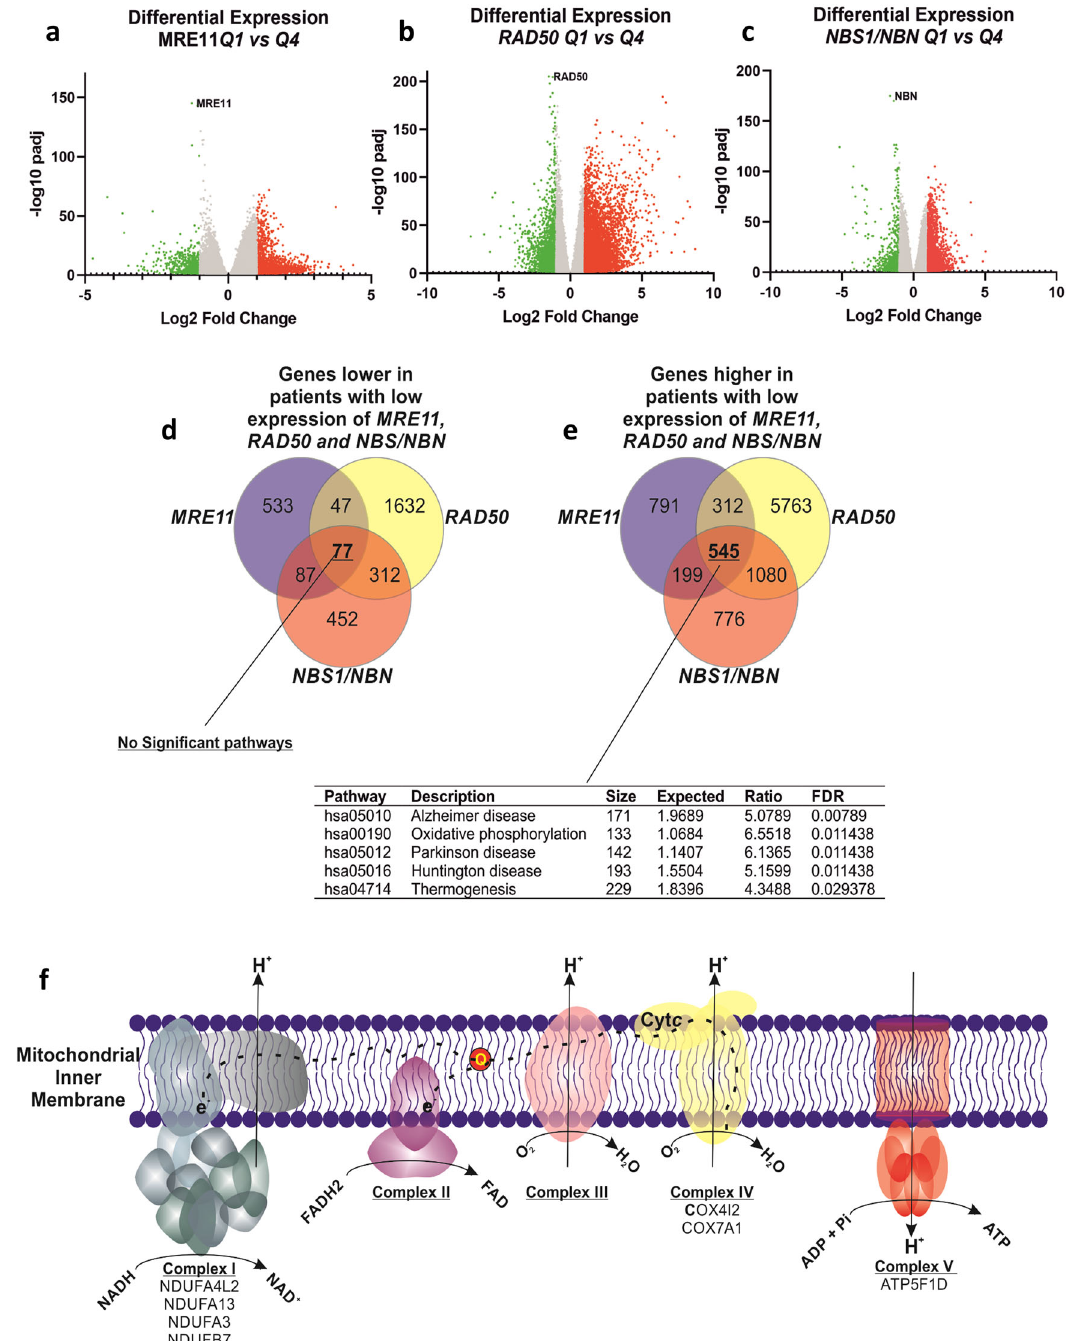
Fig. 4 MRN and genome-wide alterations. Differentially expressed genes (DEGs) were identi fi ed using RNAseq data from the TCGA-BRCA cohort dichotomized on the basis of low (quartile 1) versus high (quartile 4) expression of MRE11 ( a ) , RAD50 ( b ) and NBN/NBS1 ( c ). We next identi fi ed DEGs that were low (77 genes) or higher (545 genes) in patients with lower expression of MRN components ( d – f ) and identi fi ed enriched KEGG pathways ( d , e ). Pathways related to mitochondrial dysfunction were associated with reduced MRN expression ( f who received more modern DNA-damaging chemotherapy will be ER- and high-risk NPI. Univariate analysis showed an adverse required. At the transcriptomic level, in both whole cohorts, only prognostic signi fi cance for low nuclear MRE11 and low nuclear low RAD50 mRNA remained associated with poor survival. RAD50 expression. In multivariate analysis, low nuclear RAD50 Interestingly, in sub-group analysis, in cohort 1 ( n = 1809) low remained independently associated with poor survival. However, a RAD50 mRNA was signi fi cantly associated with poor survival in limitation of our study is that patients in this historical cohort ER − cohort but not in ER + cohort. In cohort 2 ( n = 4904), on the (1986 – 1999) received cyclophosphamide/methotrexate/5- fl urour- other hand, low RAD50 mRNA was signi fi cantly associated with acil (CMF)-based chemotherapy. To further validate the prognos- poor survival in ER + cohort but not in ER − cohort. We speculate tic/predictive signi fi cance of MRE11, additional studies in patient